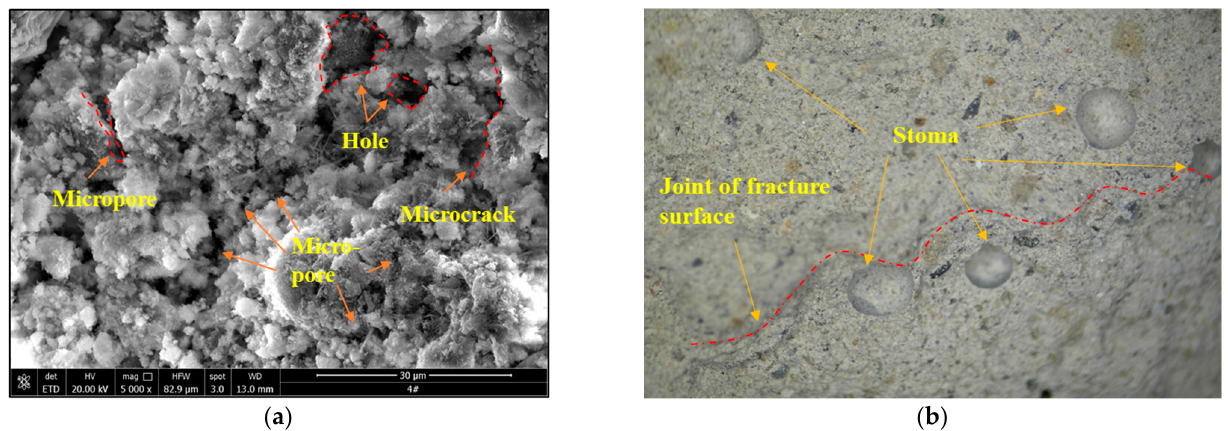
Figure 10. Microstructure of damaged backfill; ( a ) optical microscopy, ( b ) scanning electron microscopy.